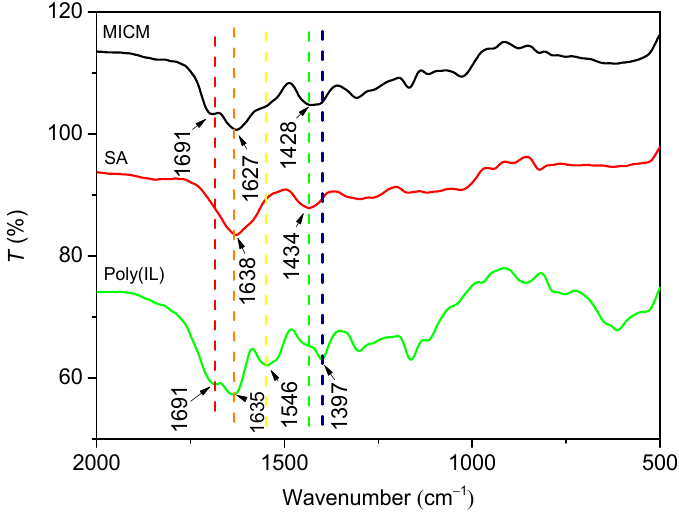
Figure 3. FT-IR spectra of MICM, SA and poly(IL). The ESR and porosity of MICM and NMICM were determined at the equilibrium time by the weighing method and plotted in Figure 4. Both ESR and porosity of MICM were higher than those of NMICM because the removal of BSA from MICM would cause more gaps and pores in the cross-linked polymer chain. The higher macropore porosity of MICM was beneficial to the mass-transport of protein.